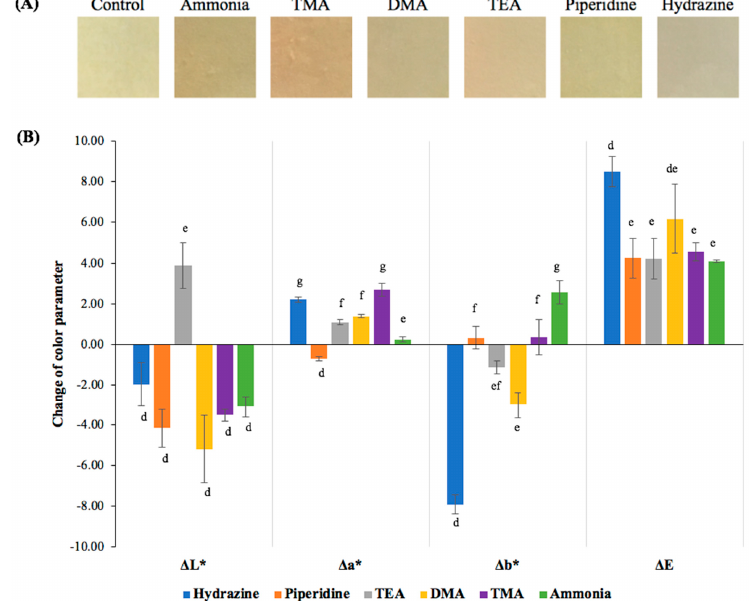
Figure 4. ( A ) Representative color responses of cinnamil-loaded 2 × 2 cm 2 cellulose papers when exposed to different volatile amines. Sample labelled as “control” depicts color without amine addition. ( B ) Changes in color parameters ( L *, a *, b * and ΔΕ ) after the exposure to different amines. TEA: triethylamine; DMA: dimethylamine; and TMA: trimethylamine. Columns of the same color parameter with different lowercase letters are significantly different ( p < 0.05).